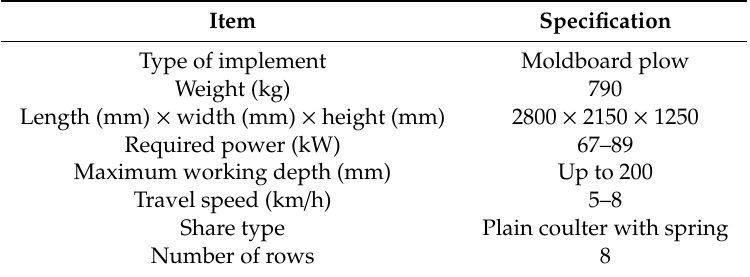
Table 2. Specification of the attached implement used in this